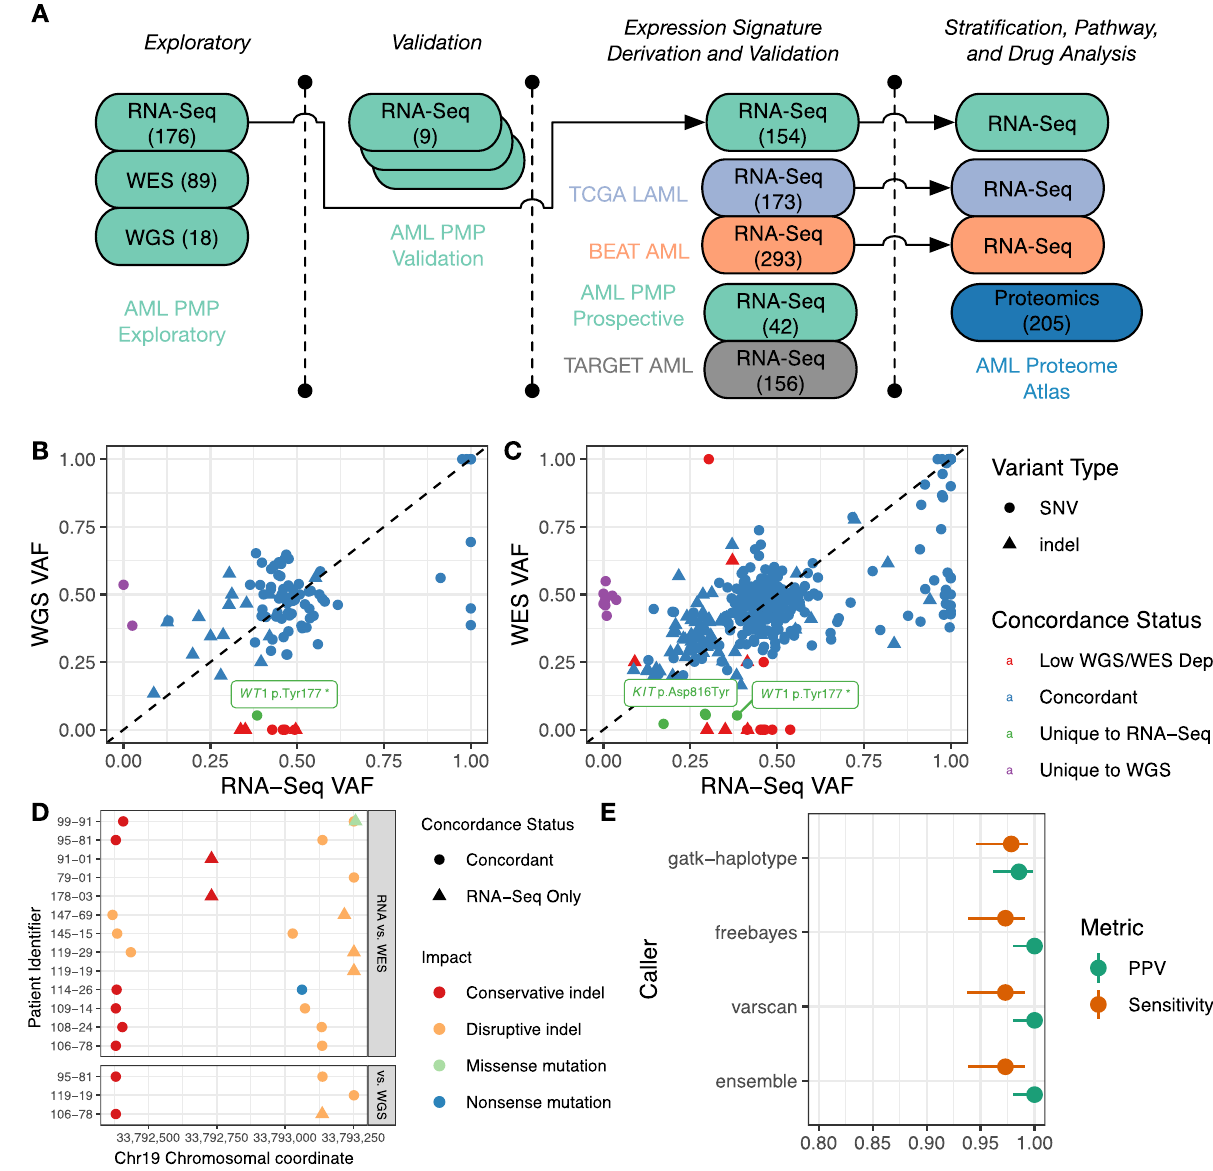
Fig. 1 Experimental overview and short nucleotide variant/indel analysis. A Overview of datasets used at each stage of the analysis, colored by sequencing project, with sample size for each data set indicated in brackets. For the AML PMP exploratory batch, MDS samples were used for pro fi ling the SNV and gene fusion pipelines, but not for expression-based analyses, and validation RNA-Seq libraries were prepared in triplicate. B – C Matched variant allele frequency (VAF) for variants between whole-genome sequencing (WGS) and RNA-Seq ( B ) and whole exome sequencing (WES) and RNA-Seq ( C ), by concordance status, variant type, and coverage status (sites with ≤ 10x coverage are indicated as ‘ Low WGS/WES Depth ’ ). Selected variants discussed in the text are labeled with Human Genome Variation Society (HGVS) nomenclature. D Variant observations in CEBPA . Potentially disruptive mutations for each patient ( y -axis) are indicated by their chromosomal coordinate ( x -axis), with predicted impact and variant concordance. E Sensitivity and positive predictive value (PPV) for each variant caller in the validation cohort (with 95% con fi dence